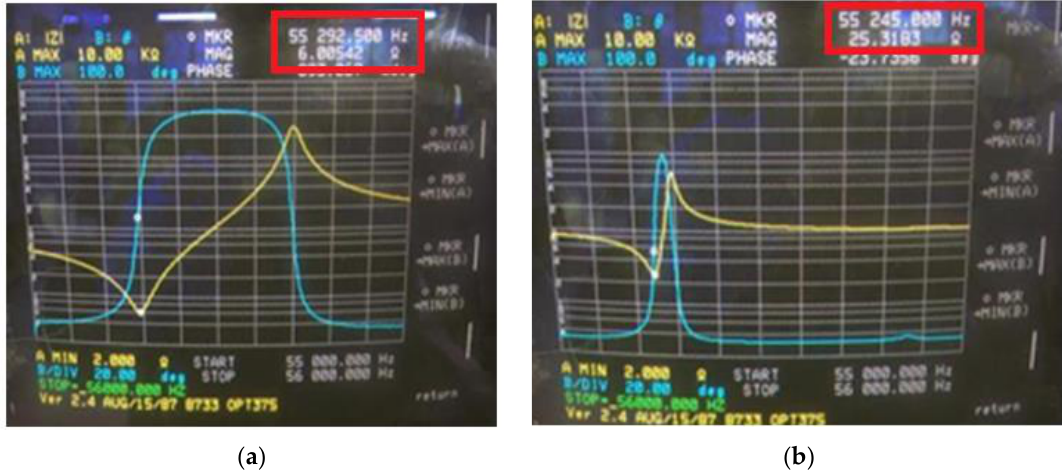
Figure 11. Measured electrical impedance versus frequency of the BLUT ( a ) with and ( b ) without waveguide.